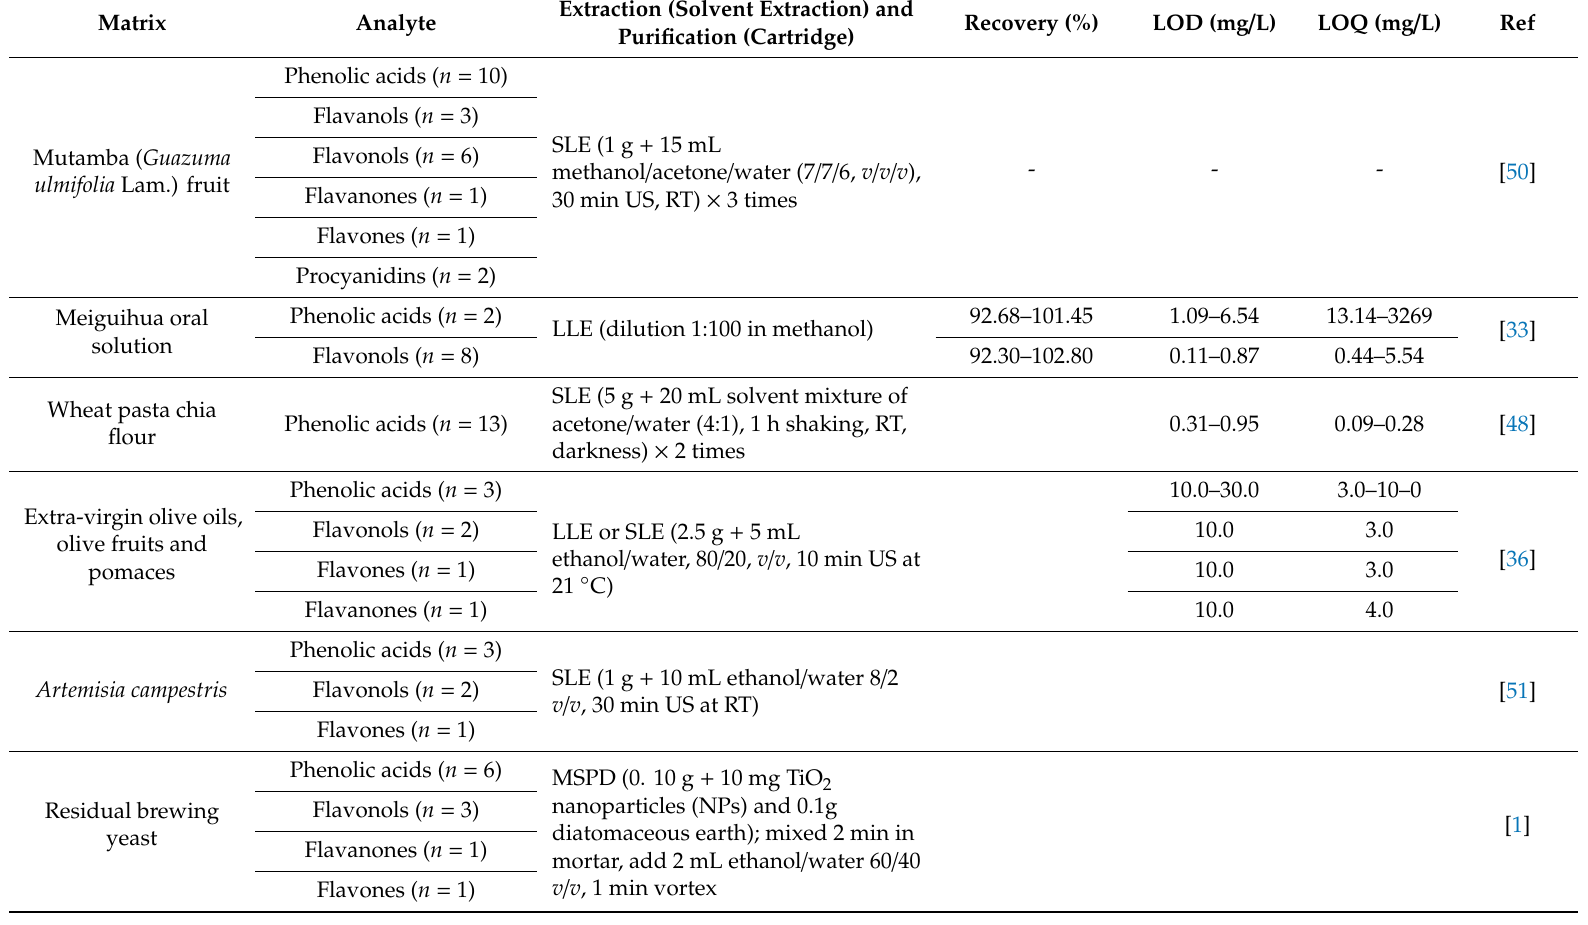
Table 1. Di ff erent conditions for the polyphenol extraction and